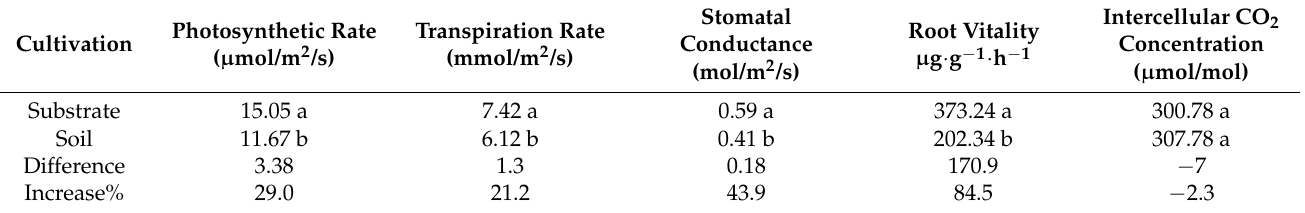
Table 5. Photosynthetic characteristics and root activity of tomato under substrate and soil cultivation conditions.